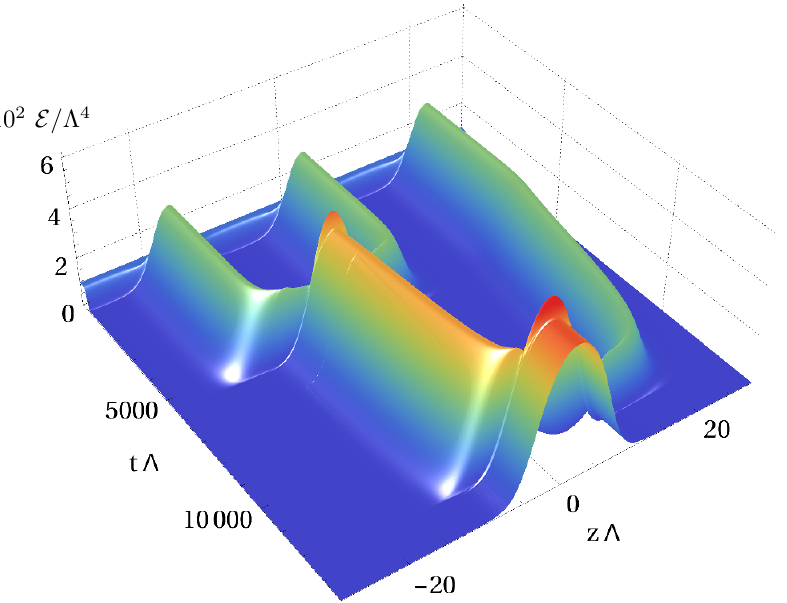
Figure 23 . Evolution up to t (cid:3) = 13790 of the energy density of the initial state considered in [26], which has E ( t = 0) = E 5 ; L (cid:3) ’ 57 and initial mode n =